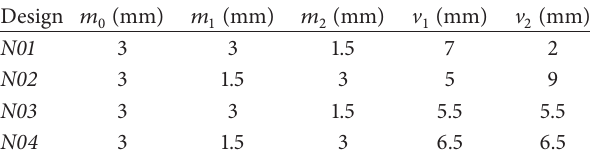
Table 11: Simulated two-layer sandwich-type CLD designs. Design 𝑚 0 (mm)